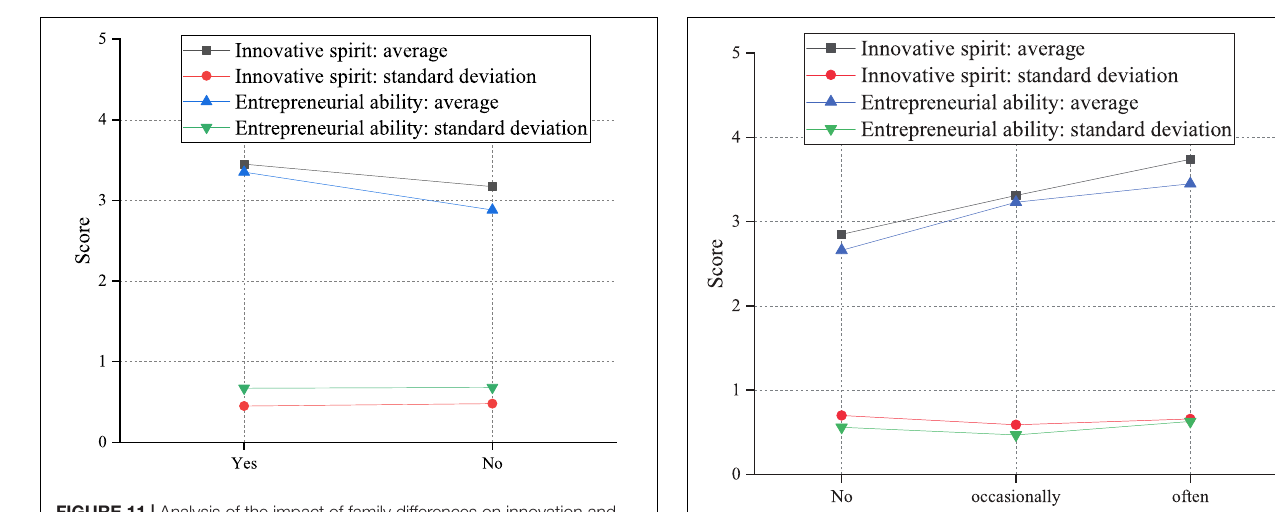
FIGURE 11 | Analysis of the impact of family differences on innovation and entrepreneurship ability of college students.